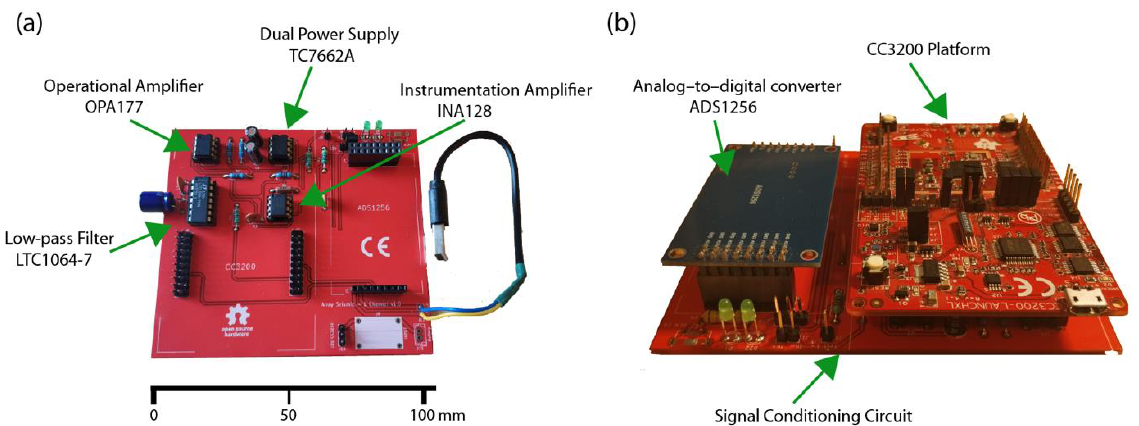
Figure 3. ( a ) Prototype of the signal conditioning circuit in PCB ( b ) Assembly of the complete system, with the conditioning circuit, the ADS1256, and the Launchpad CC3200.